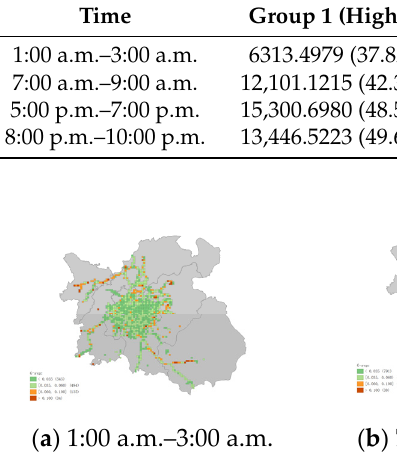
Figure 14. ( a ) Grid average carbon emissions (G-avgc) of each grid area at 1:00 a.m.–3:00 a.m. ( b ) Grid average carbon emissions (G-avgc) of each grid area at 7:00 a.m.–9:00 a.m. ( c ) Grid average carbon emissions (G-avgc) of each grid area at 5:00 p.m.–7:00 p.m. ( d ) Grid average carbon emissions (G-avgc) of each grid area at 8:00 p.m.–10:00 p.m.